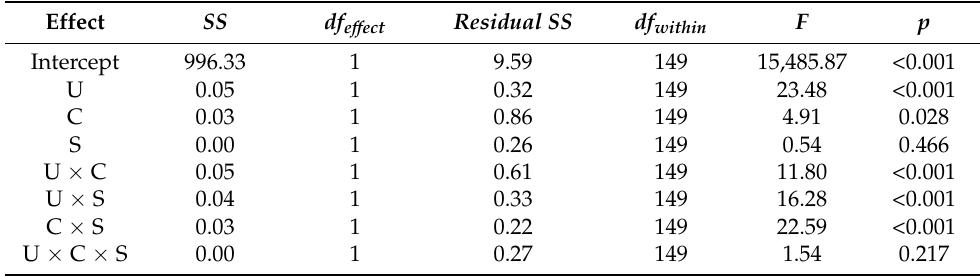
Table A1. Significance testing of accuracy effects using a generalized linear model with a probit link function.